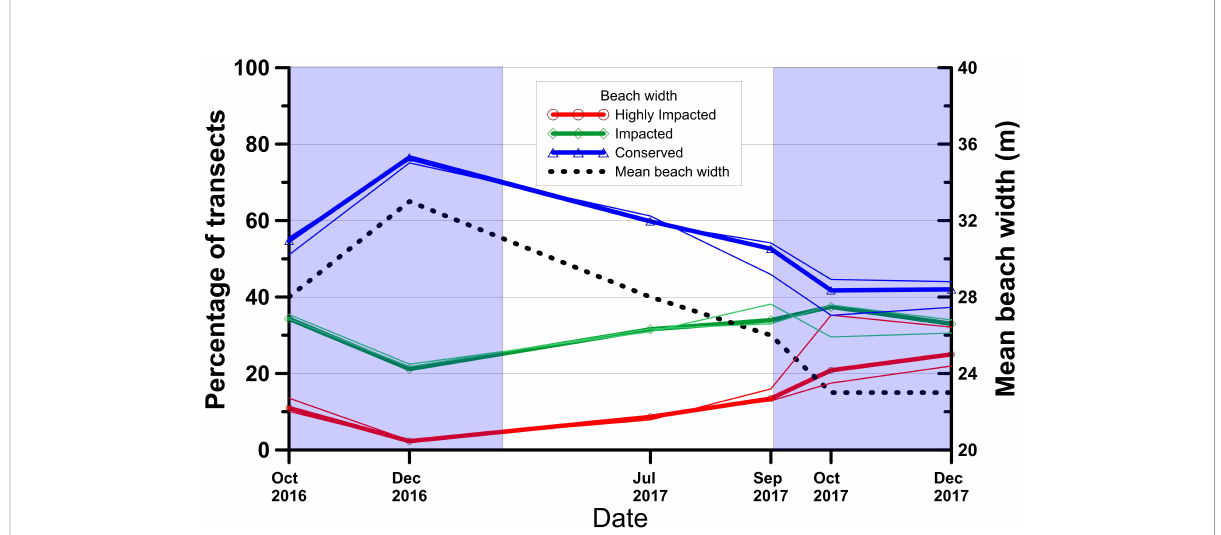
FIGURE 4 Progression of the beach width indicator presented as the percentage of transects belonging to each of the three different categories (red line - Highly Impacted class, green line - Impacted class and blue line - Conserved class) and the mean beach width for all the transects (black dotted line) along the 14 months of study. Blue shaded areas correspond to Nortes season and white areas correspond to sea breeze dominating